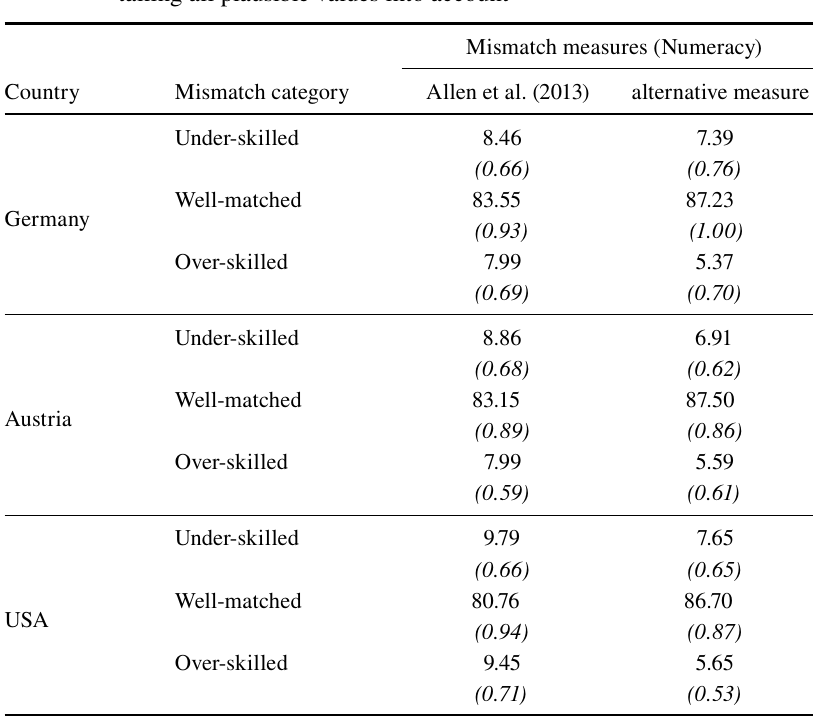
Share of mismatched workers by definition of skill mismatch taking all plausible values into